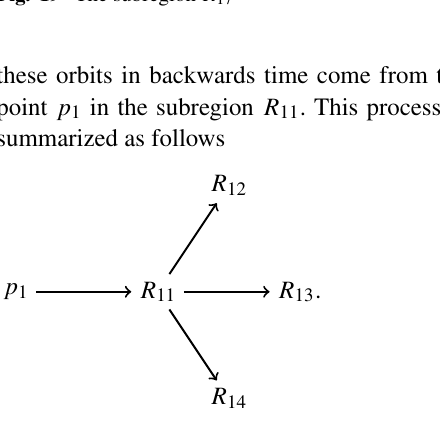
Fig. 16 The subregion R 14